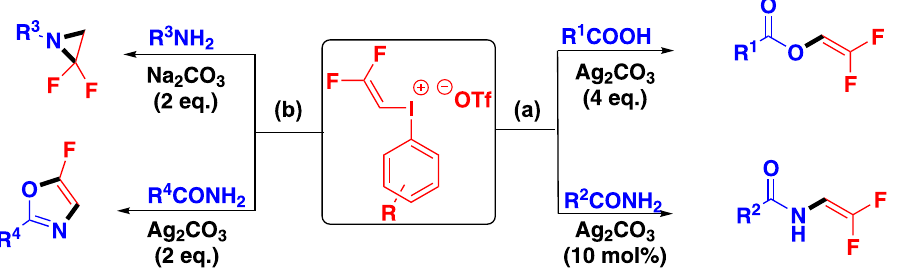
Fig. 2 The structure and reaction modes of novel gem-di fl uorovinyl hypervalent iodine reagent (DFVI). a gem-Di fl uorovinyl iodonium salt acted as